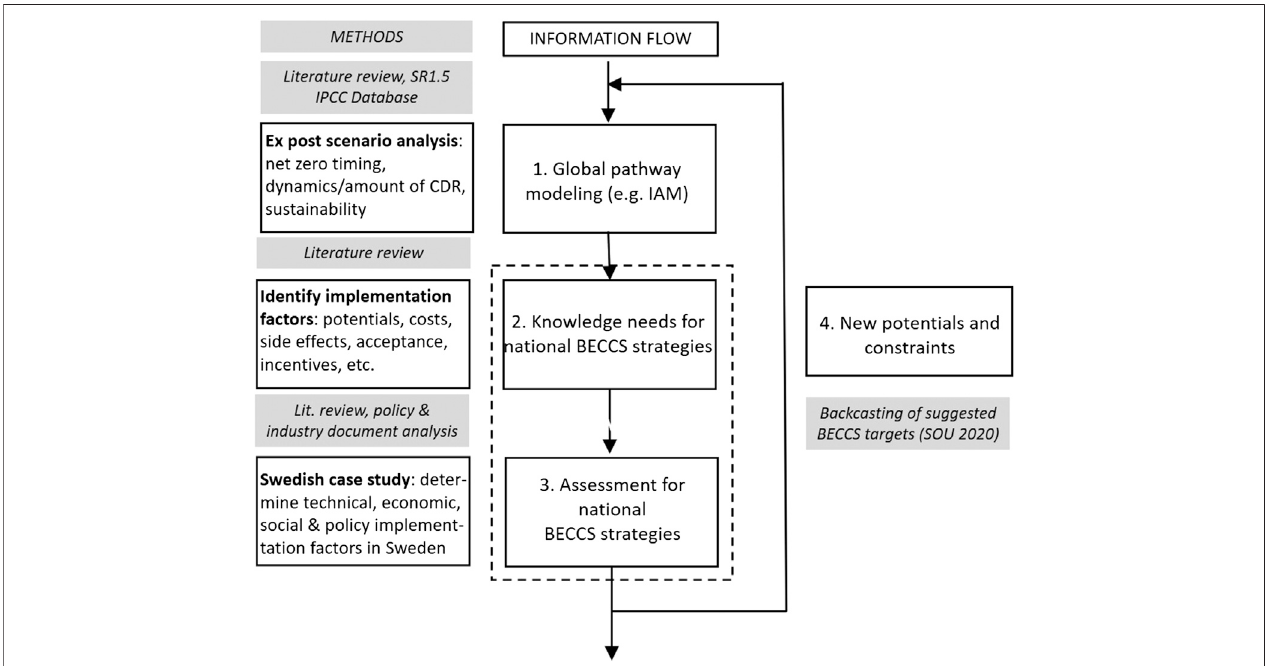
FIGURE1| SchematicoftheprocedureforassessingtheroleofBECCSthroughlinkingnationalstrategiestoglobalpathwaymodelingsystemssuchasIntegrated Assessment Modeling